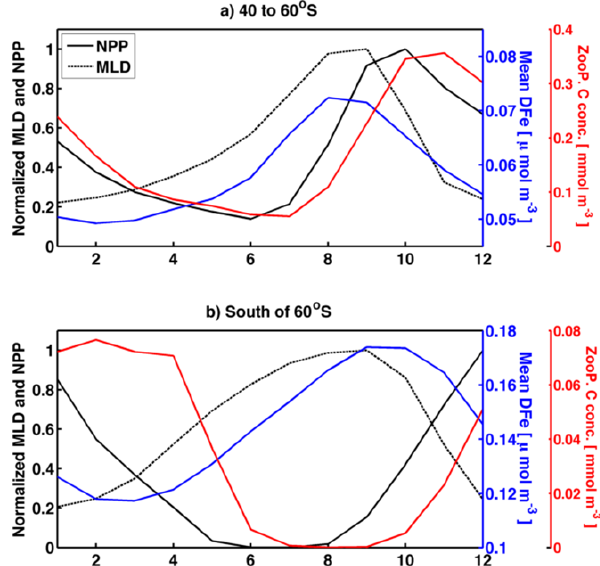
Figure 20. Seasonal change in the modelled NPP, MLD, DFe and zooplankton concentration for (a) the Southern Ocean from 40 to 60 ◦ S and (b) south of 60 ◦ S. DFe and zooplankton concentrations are averaged over the top 100m of the ocean. NPP and MLD are normalized by the maximum of the monthly